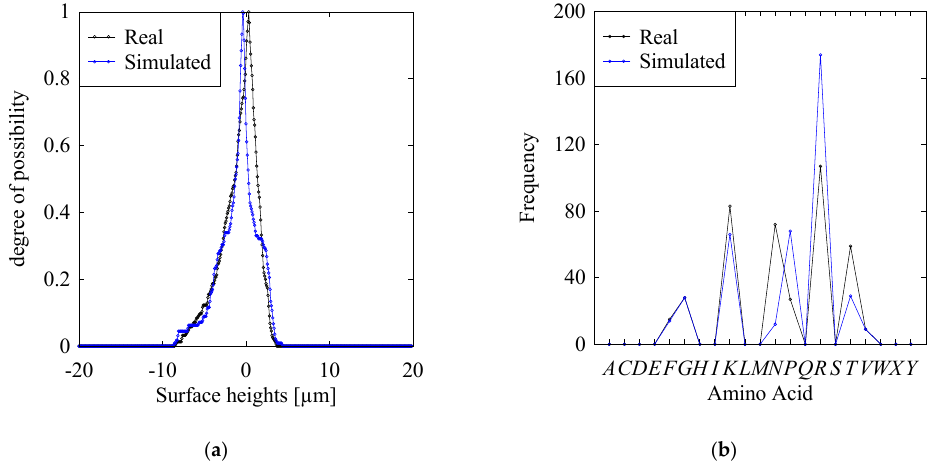
Figure 7. Outcomes of discrete event Monte Carlo simulation-based SC associated with Markov chain- based MC: ( a ) simulated surface heights; ( b ) return map of ( a ).